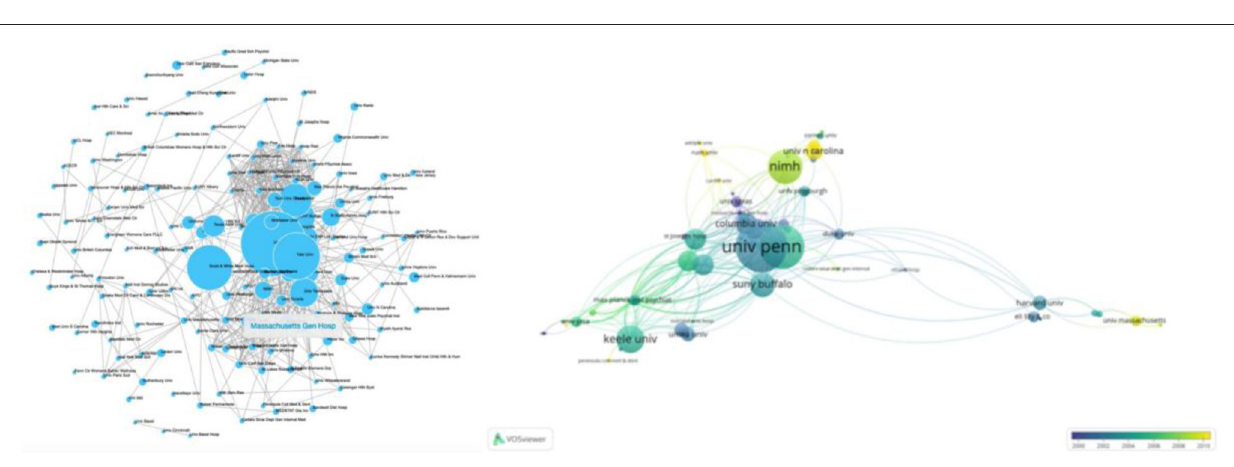
FIGURE 6 | Network visualization of the institutions that contributed to the top 100 cited articles. The size of the circle represents the number of papers in the top 100 list.